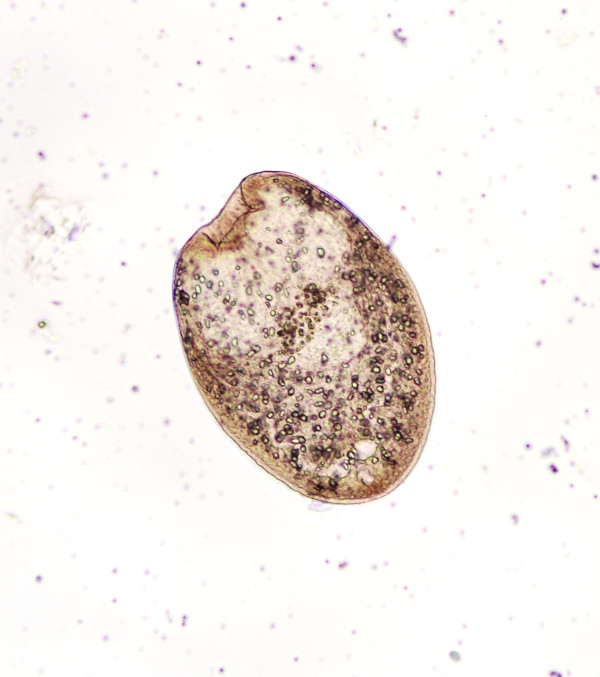
Developmental stage of a metacestode with scattered rostellar hooklets.